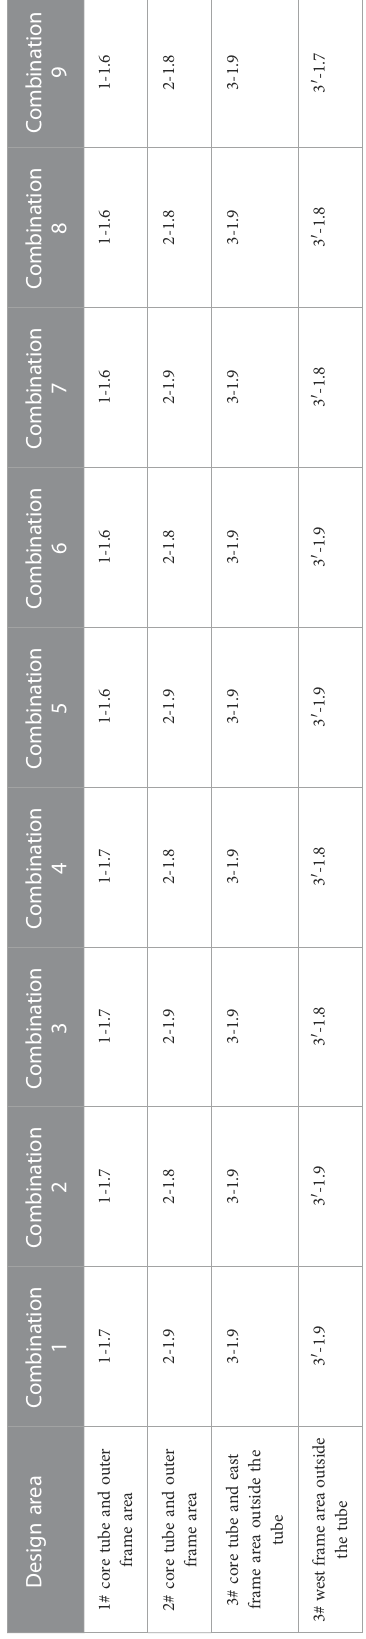
Note: λ -Single pile bearing capacity exertion coef fi cient; R a -Characteristic value of vertical bearing capacity of single pile, kN ; A p -Sectional area of pile, m 2 ; β -Exertion coef fi cient of bearing capacity of soil between piles; The bearing capacity characteristic value of single reinforced